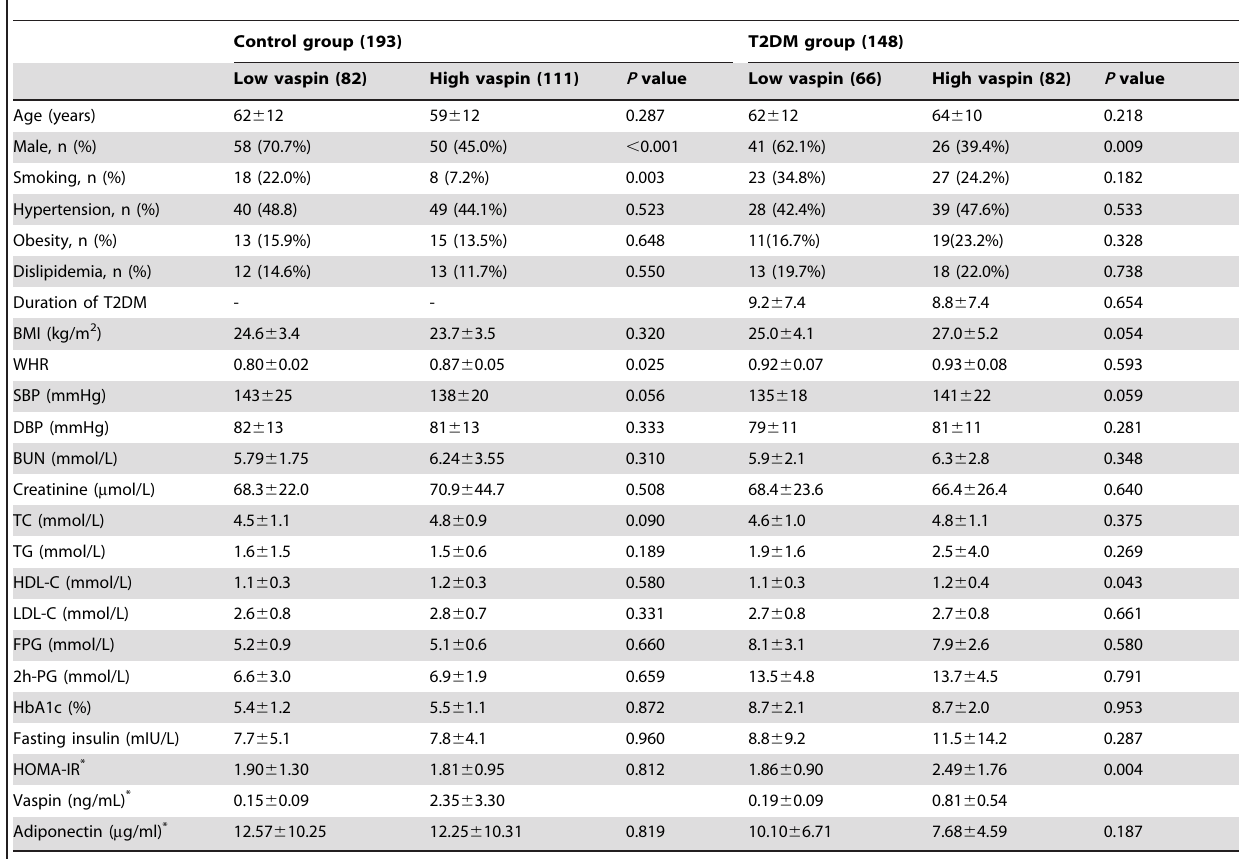
Table 1. Basic clinical characteristics of all subjects at